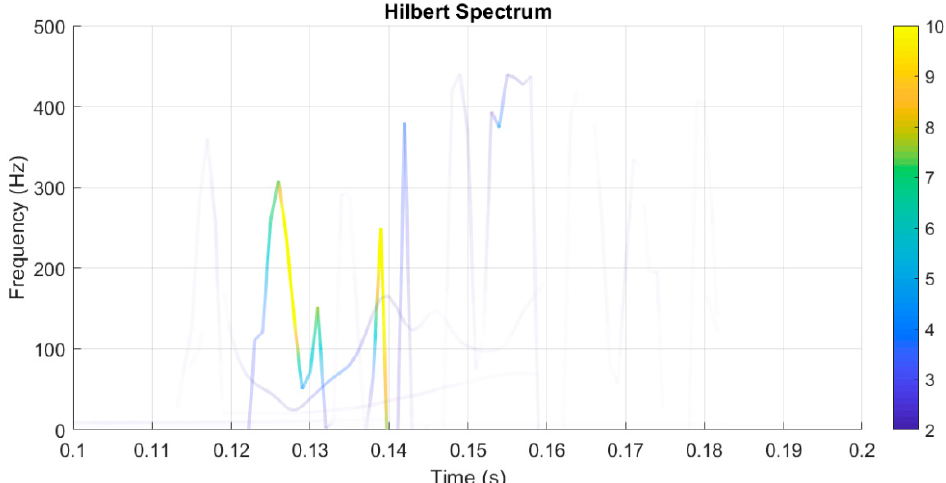
Figure 7. Example of the frequency data analysis according to the Hilbert–Huang transform (HHT) transform; on the x-axis is the elapsed time of the signal and along the y-axis the frequency, and the color scale refers to the signal amplitude at that given frequency and time signal.